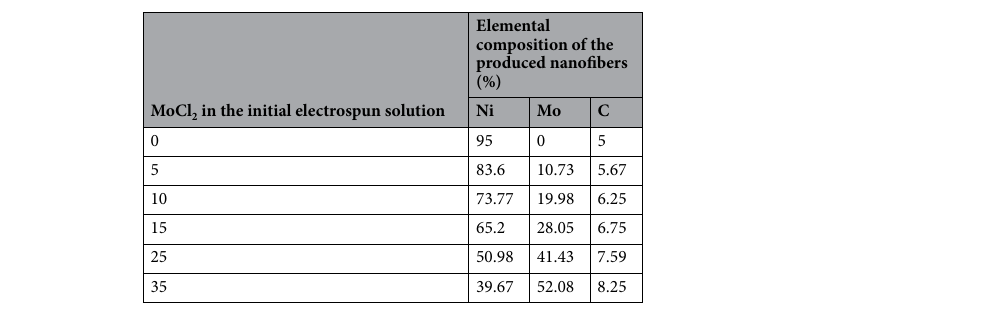
Table 1. Elemental composition of the produced nanofibers.